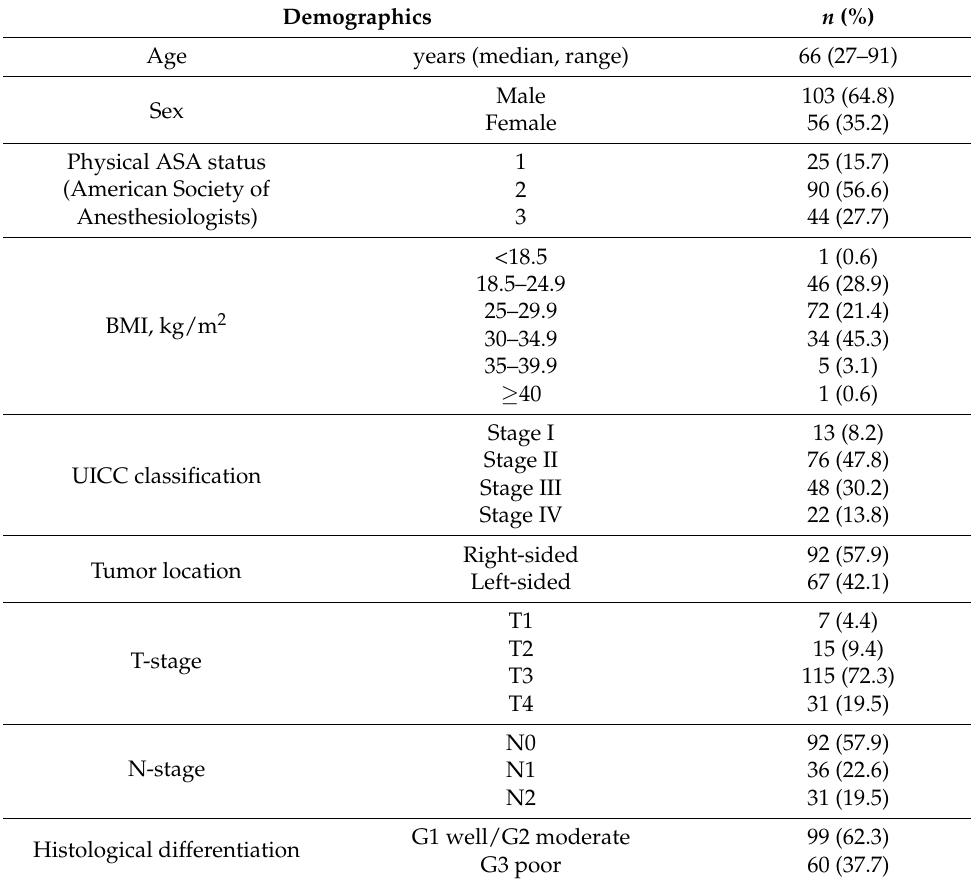
Table 1. Clinical characteristics of patients in the discovery cohort.